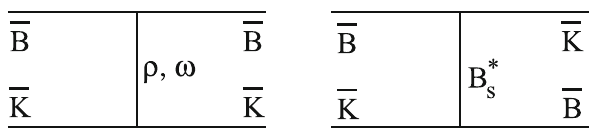
Fig. 2 Vector meson exchange for the ¯ B ¯ K